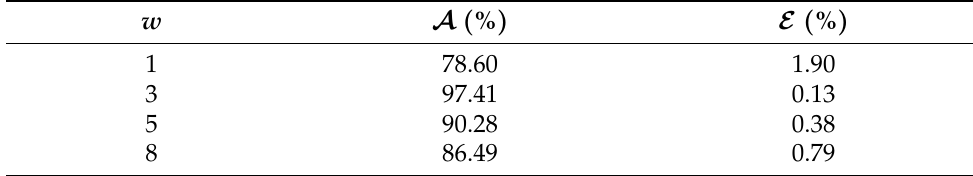
Table 3. Performance analysis for different w